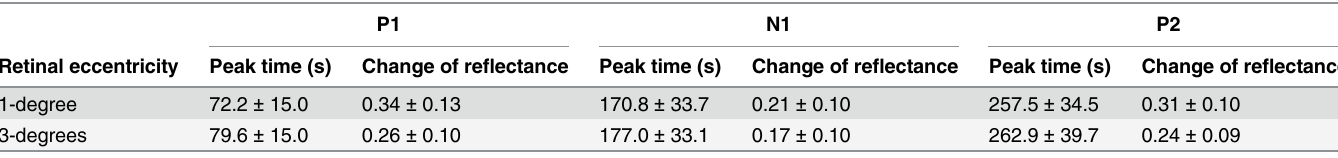
Table 2. Peak time and change of cone reflectance ( Δ